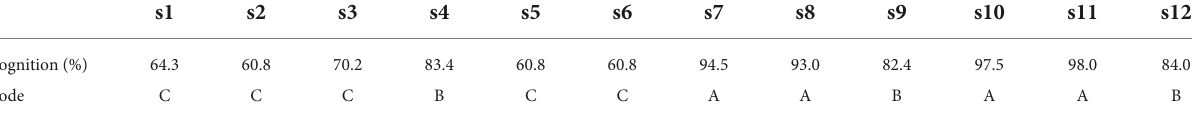
TABLE 5 Cognition of in-service